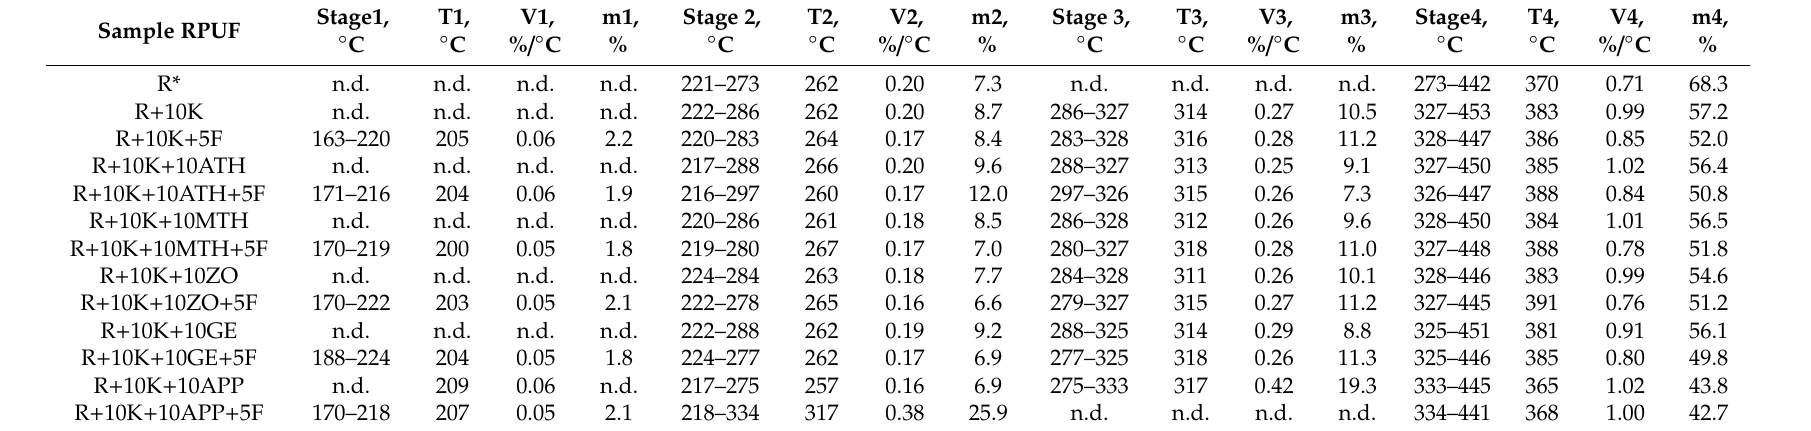
Table 4. Results of DTG curves analysis obtained by TGA measurements in nitrogen